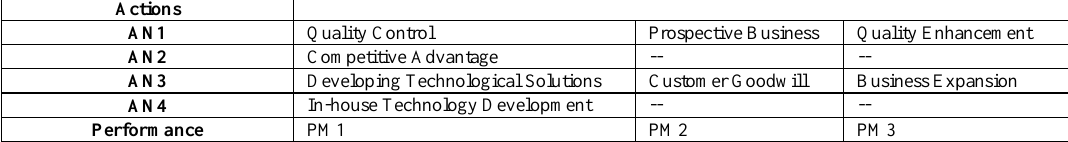
Table 13. Cross interaction interpretive matrix for actions and performance in interpretive